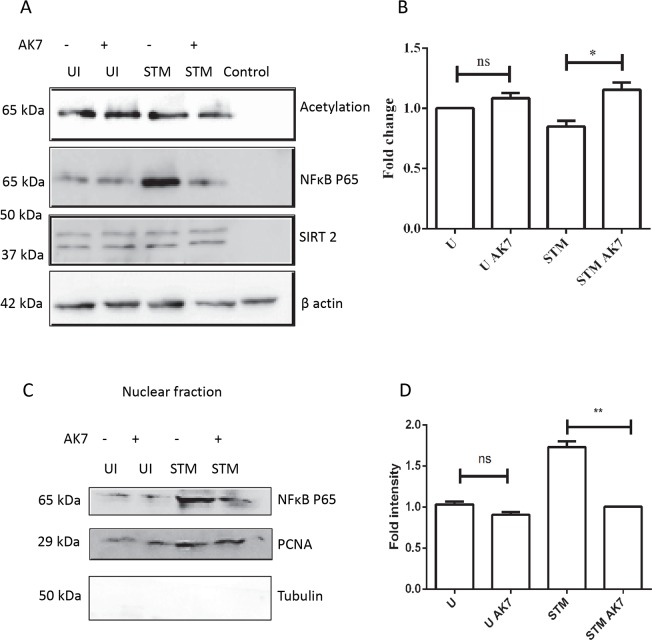
SIRT2 modulates p65 translocation to the nucleus.A. Representative immunoblot of SIRT2 co-IP, probed for NFκB p65 and acetylation in the presence and absence of SIRT2 inhibition at 20 h post infection. (UI- uninfected DCs, UI AK7- Uninfected DCs treated with 10 μM AK7, STM- Salmonella Typhimurium infected DCs, STM AK7- Salmonella Typhimurium infected DCs treated with 10 μM AK7, Control- Isotype control) (SIRT2+/+DCs were used for the purpose of this experiment). B. Densitometry analysis of immunoblot of SIRT2 co-IP, probed for NFκB p65 and acetylation in the presence and in absence of SIRT2 inhibition at 20 h post infection. (UI- uninfected DCs, UI AK7- Uninfected DCs treated with 10 μM AK7, STM- Salmonella Typhimurium infected DCs, STM AK7- Salmonella Typhimurium infected DCs treated with 10 μM AK7) (Data are presented as mean ± SEM of 3 independent experiments) C. Representative immunoblot of NFκB p65 and PCNA in nuclear isolate. (UI- uninfected DCs, UI AK7- Uninfected DCs treated with 10 μM AK7, STM- Salmonella Typhimurium infected DCs, STM AK7- Salmonella Typhimurium infected DCs treated with 10 μM AK7) D. Densitometry analysis of immunoblots of NFκB p65 and PCNA in nuclear isolate. (UI- uninfected DCs, UI AK7- Uninfected DCs treated with 10 μM AK7, STM- Salmonella Typhimurium infected DCs, STM AK7- Salmonella Typhimurium infected DCs treated with 10 μM AK7) (Data are presented as mean ± SEM of 3 independent experiments). (unpaired two-tailed Student’s t-test, p-value, *** < 0.0001, **<0.001, *<0.01).